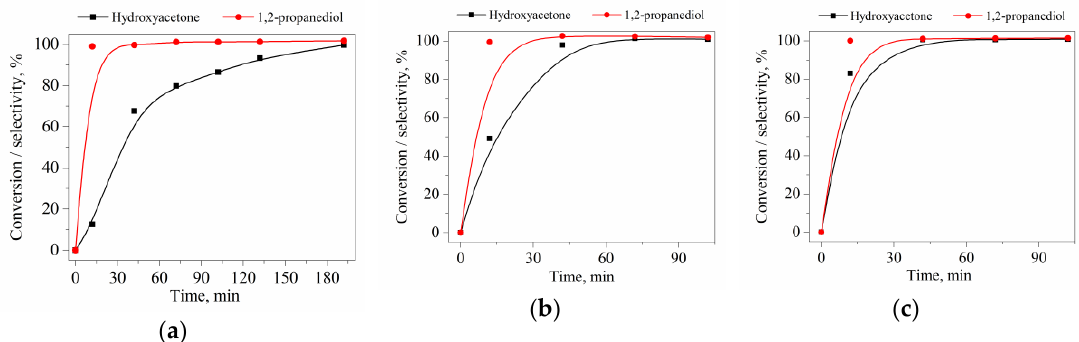
Figure 5. Effect of the reaction time on the conversion of hydroxyacetone and product selectivity of products at different temperatures (( a ): 150 °C, 3.5 MPa; ( b ): 200 °C, 3.5 MPa; ( c ), 240 °C, 3.5 MPa).